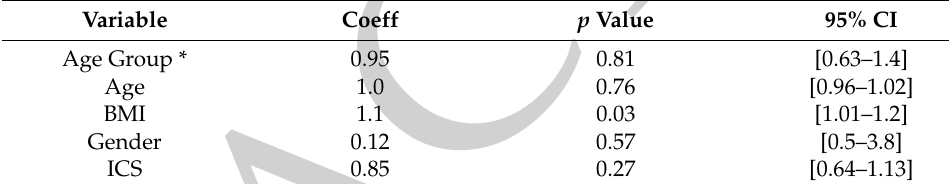
Legend: Coefficients represent the change in the Odds Ratio of detecting a vulnerable intercostal artery (VICA) when all other variables are held constant. ICS: Intercostal Space; ICA: Intercostal Artery; OR: Odds Ratio; BMI: Basal Metabolic Index. Statistical significance was defined as a p -value of less than 0.05. * Age Group: Patients were divided into 4 groups 18–49, 50–59, 60–69 and ≥ 70 years of